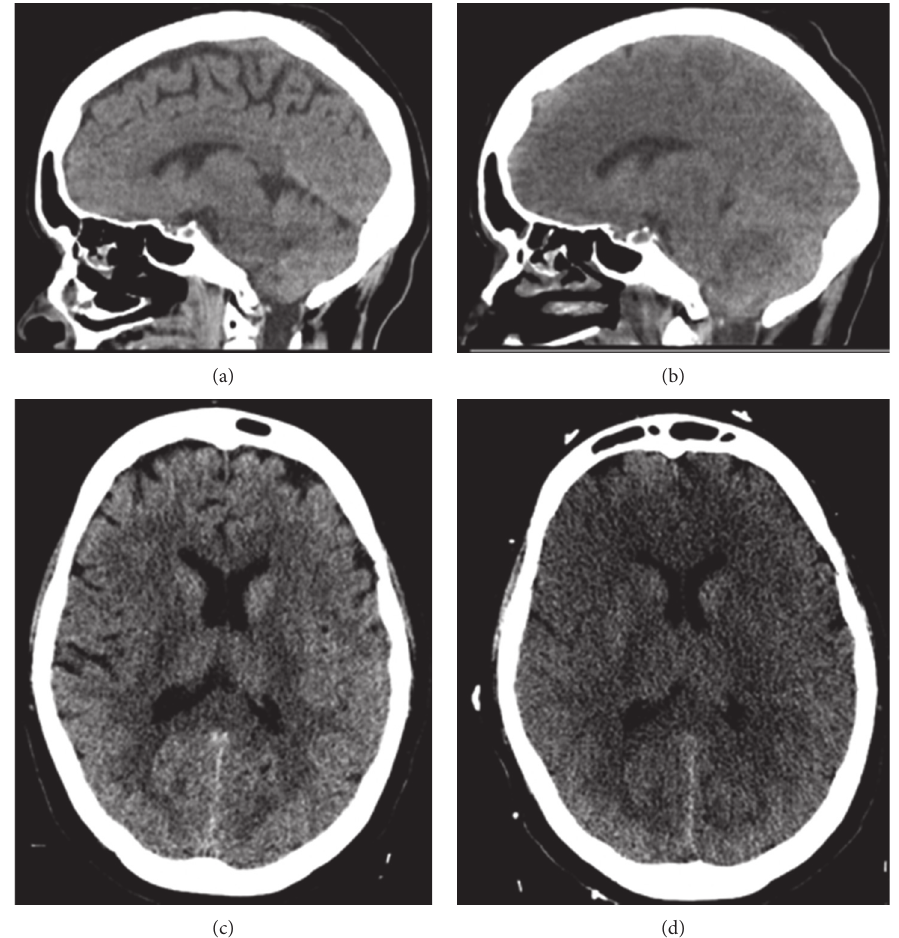
Figure 3: Sagittal and axial head CT performed before and 12 hours after the patient developed severe hyperammonemia. (a, b) Normal sagittal and axial brain CT. (c, d). Repeat head CTafter clinical deterioration revealed diffuse hypodense cytotoxic edema with compression of the lateral ventricles and sulcal effacement. Sagittal view demonstrates interval compression of the subarachnoid cisterns and cerebellar tonsil